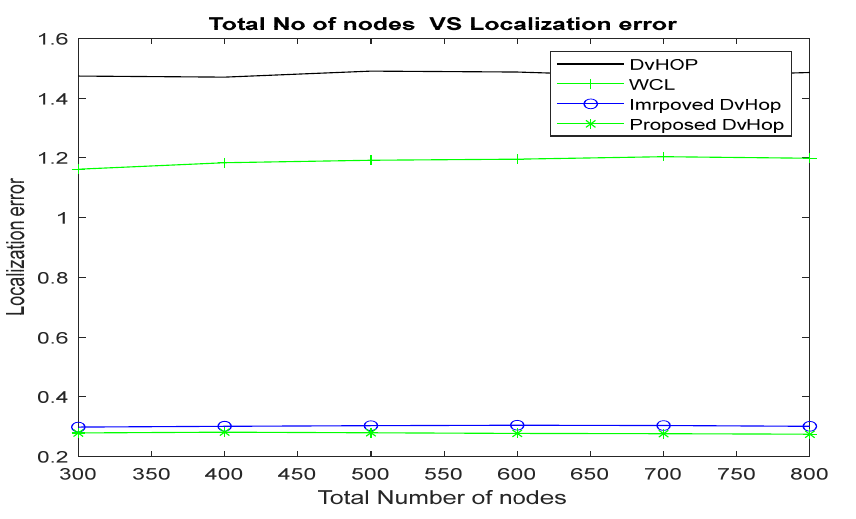
Table 8. Comparison of localization error under various anchor node ratios .